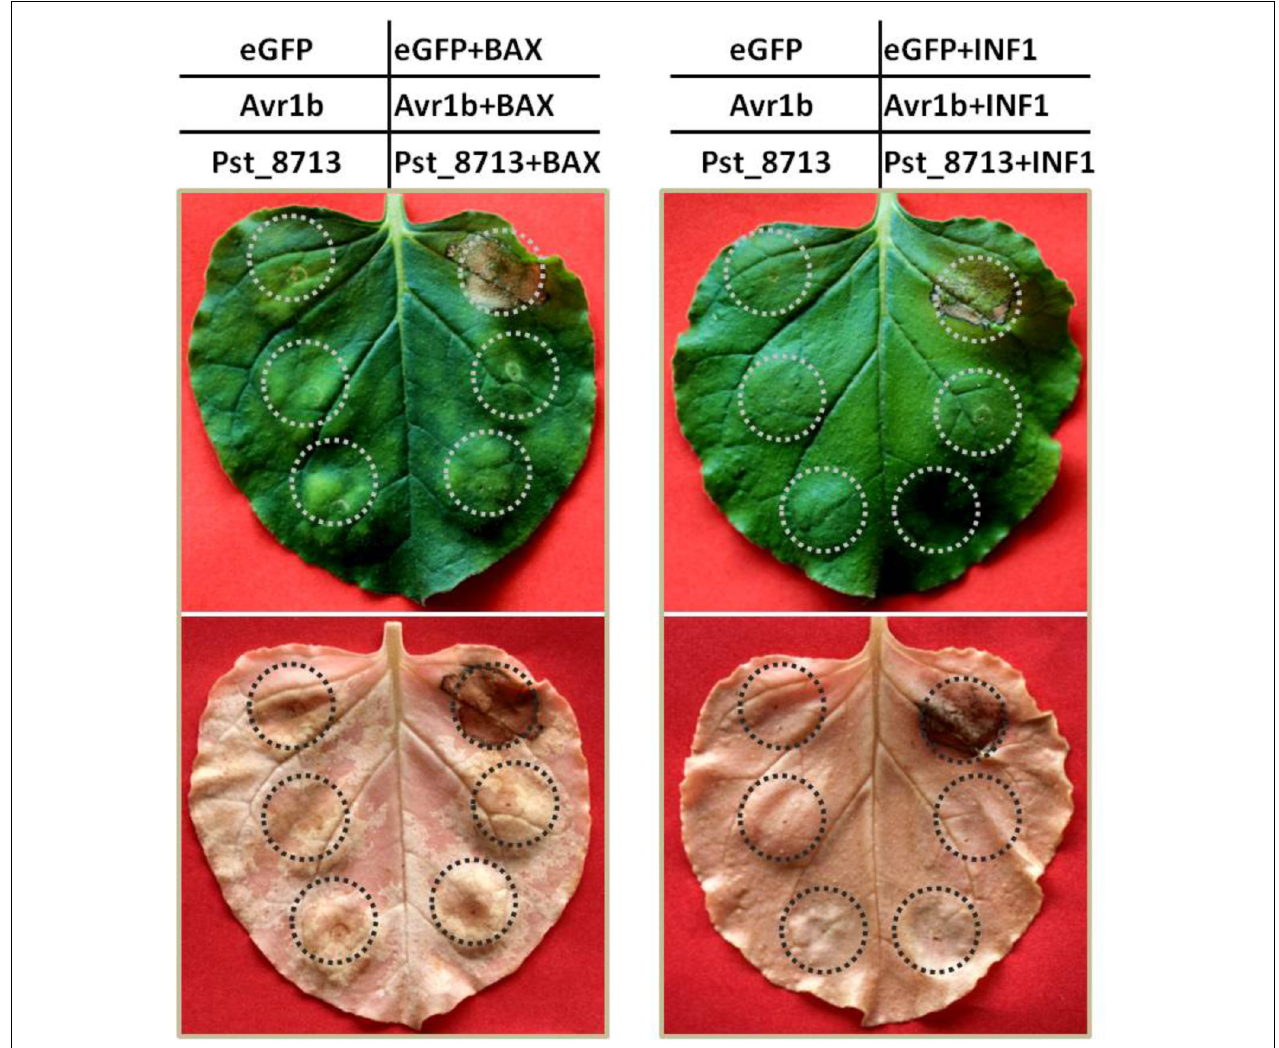
FIGURE 4 | Overexpression of Pst_8713 in N. benthamiana suppressed programmed cell death triggered by BAX and PAMP-INF1. N. benthamiana leaves were infiltrated with A. tumefaciens cells containing PVX vector carrying eGFP (negative control), Avr1b (positive control) or Pst_8713, respectively, by inoculation with A. tumefaciens cells carrying PVX:BAX/INF1 24 h later. Photos were taken 5 days after infiltration, and the leaves were decolorized with